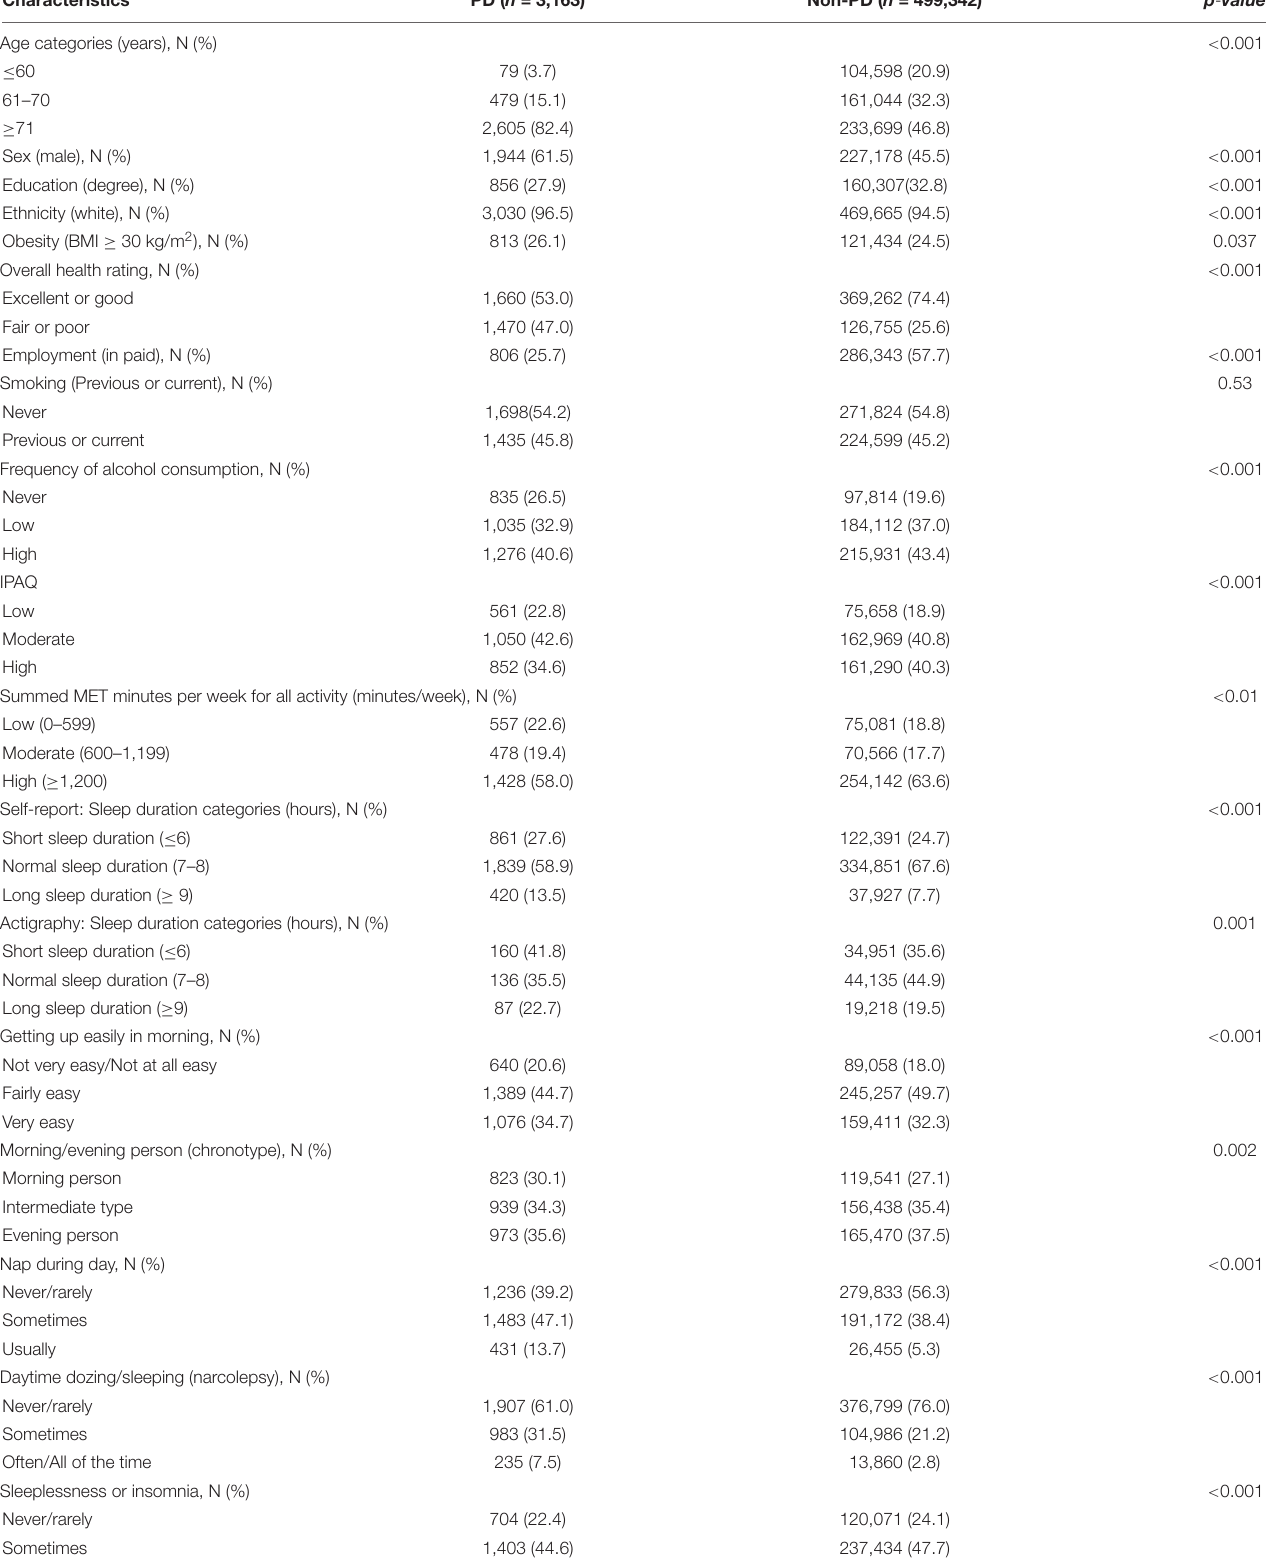
TABLE 1 | Baseline characteristics of the UK Biobank population, separated by Parkinson’s disease.